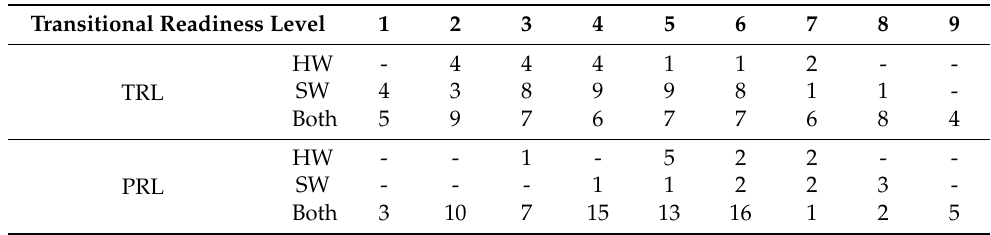
Table 1. Summary of the queries per technological, programmatic, and maintenance readiness levels, further classified in HW and SW